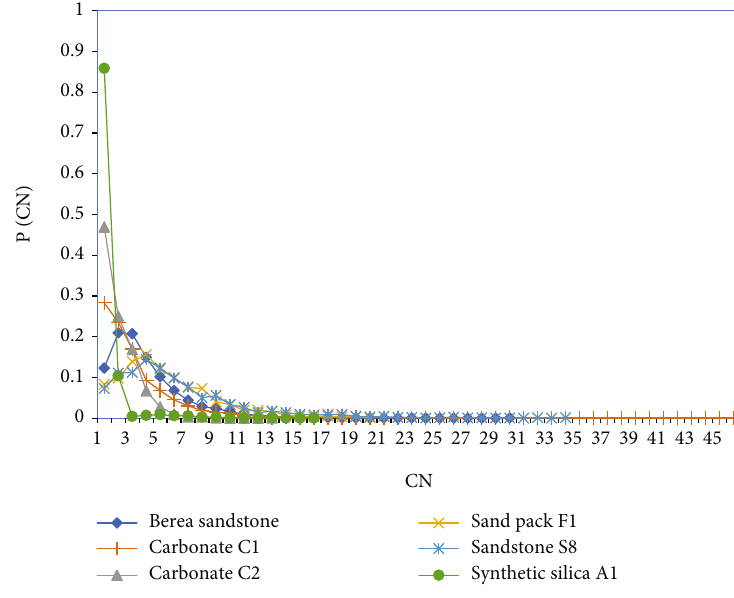
Figure 2: Degree distribution of three-dimensional pore